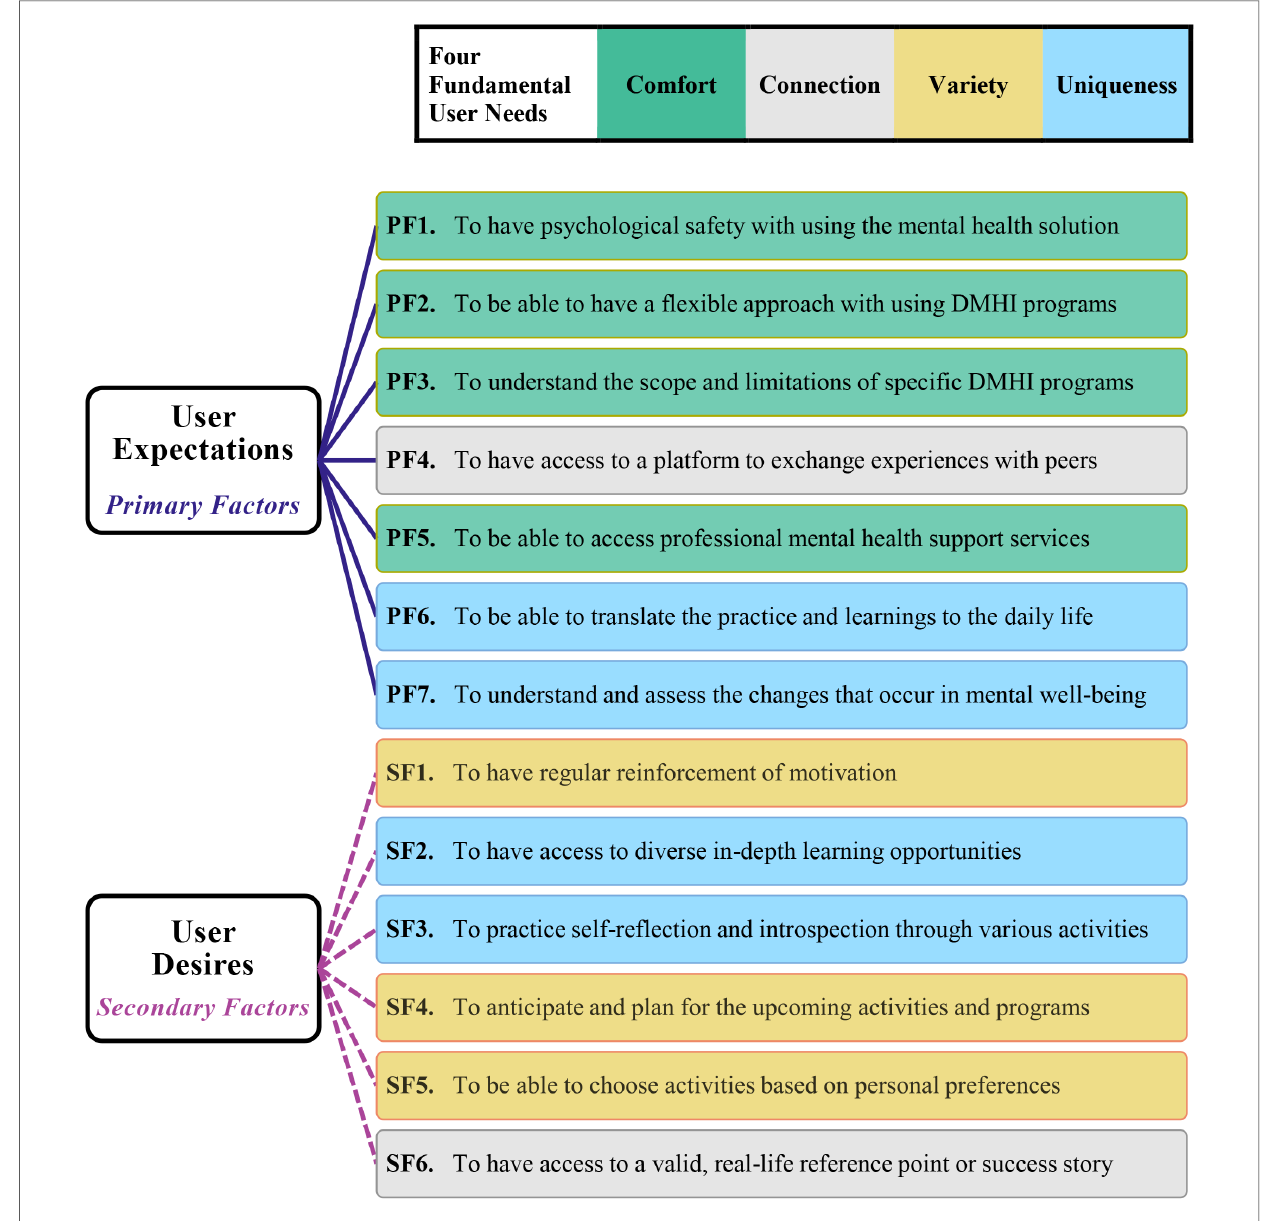
FIGURE 1 Primary and secondary factors facilitating user engagement with DMHIs. Note . The color scheme of each primary factor (PF#) and each secondary factor (SF#) corresponds to the color scheme representing the four fundamental user